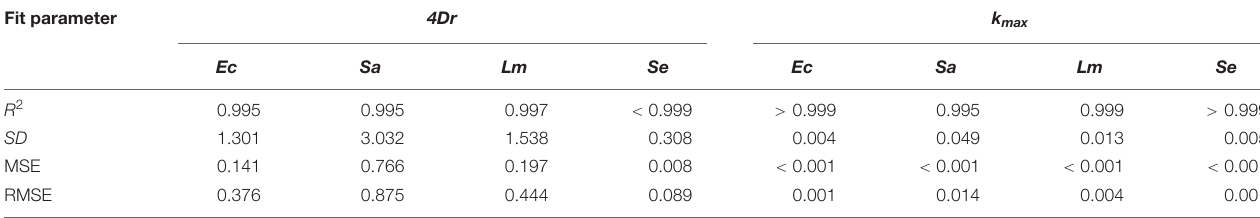
TABLE 3 | Goodness of fit statistics of the models deduced for the estimation of the inhibition curve parameters, according to the pathogen. Fit parameter